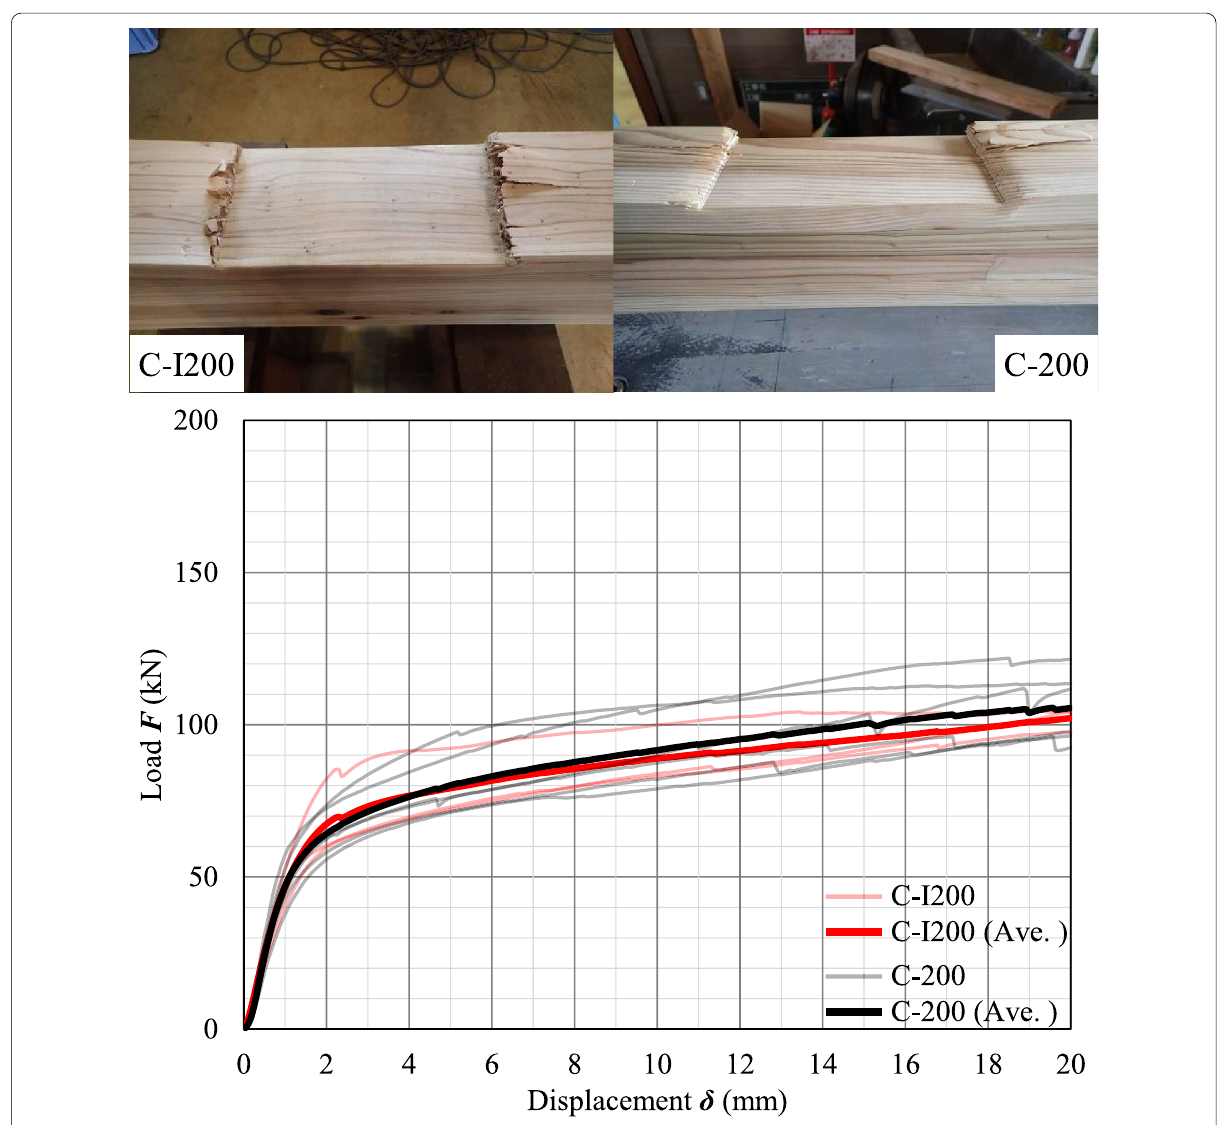
Fig. 21 Relationship between the force point load F and displacement δ of C-I200 and